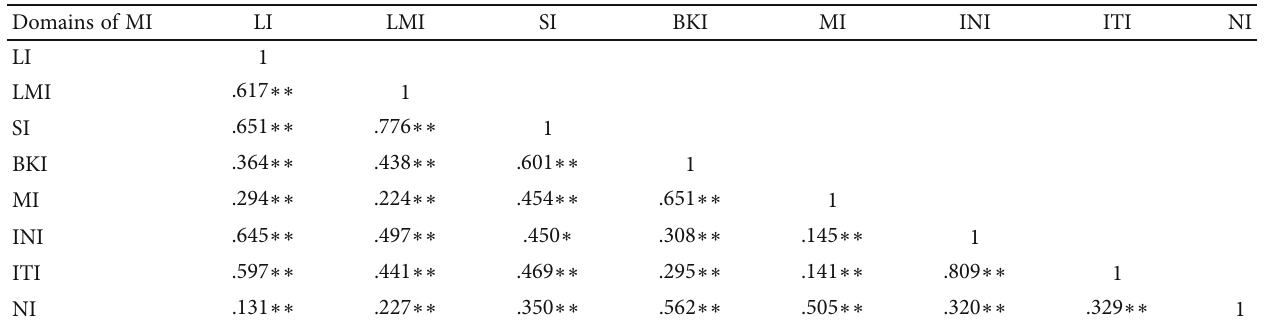
Table 3: Correlation matrix for domains of multiple intelligences.